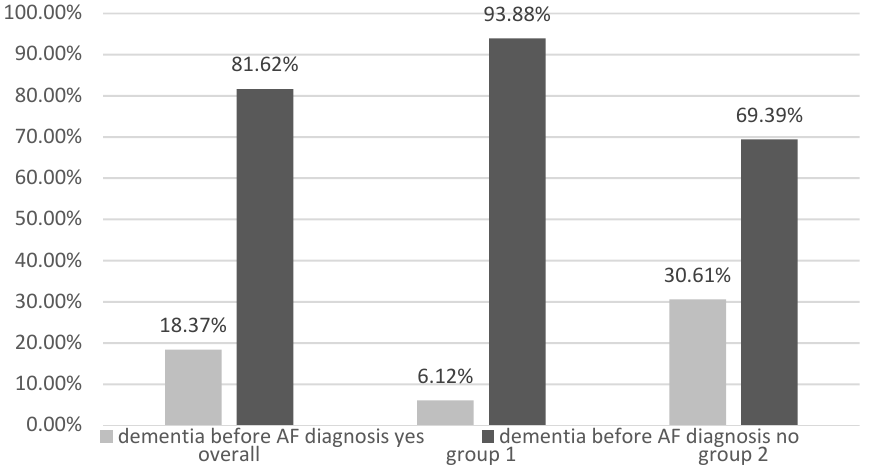
Figure 3. Incidence of dementia before AF diagnosis (AF—atrial fibrillation, group 1—paroxysmal AF, group 2—permanent AF).